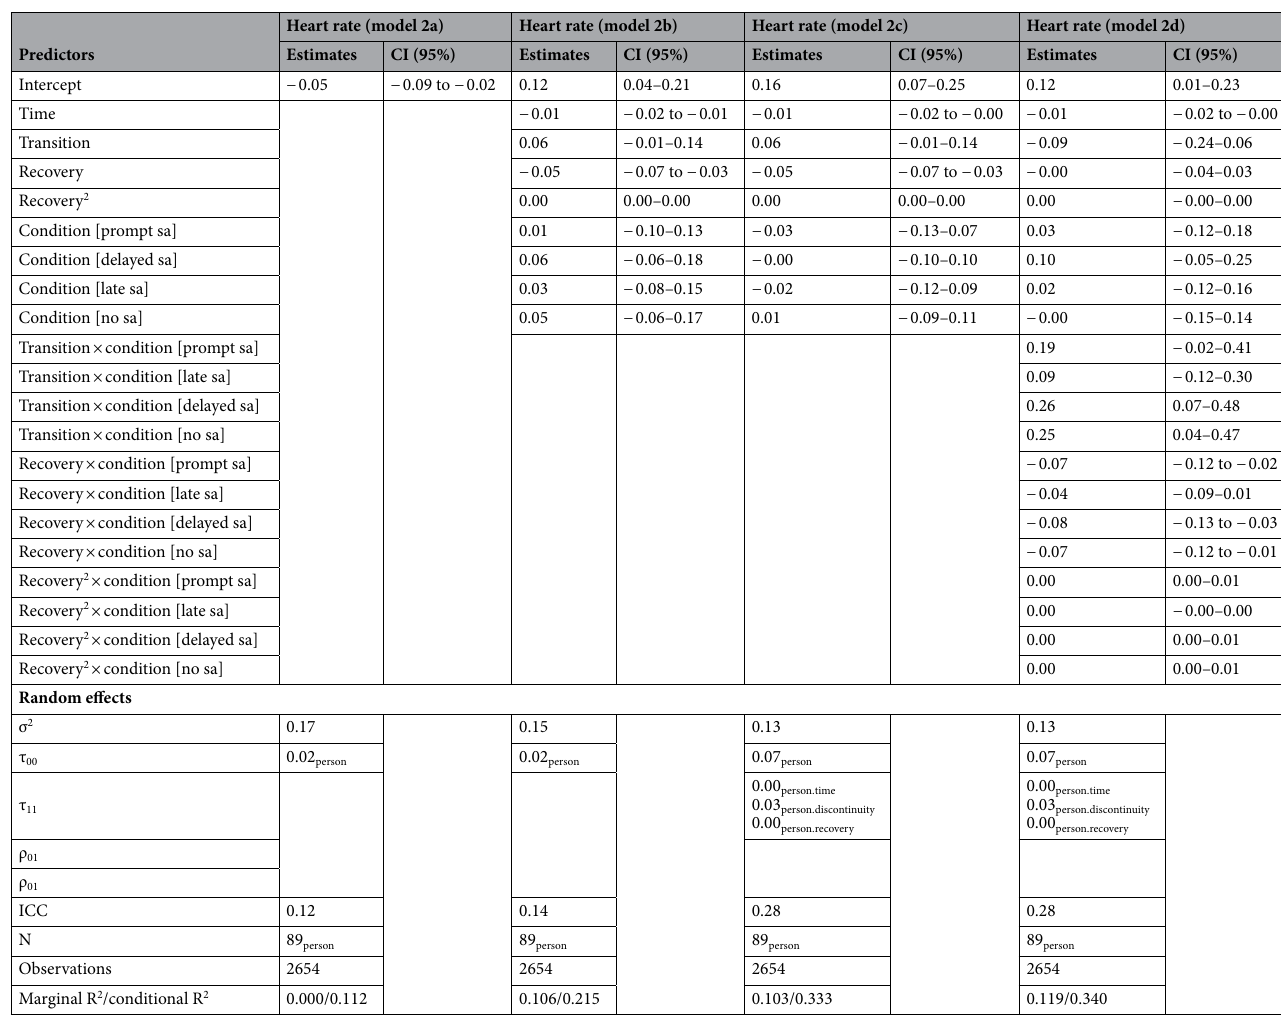
Table 3. Parameter estimates for discontinuous random coefficient models used to estimate effect of social account timing on HR. One participant was excluded from this analysis because the trial transitions were not recorded correctly in E-prime during the experiment. Condition contains five levels (fulfillment, no social account, prompt social account, delayed social account, and late social account), with fulfillment used as comparison